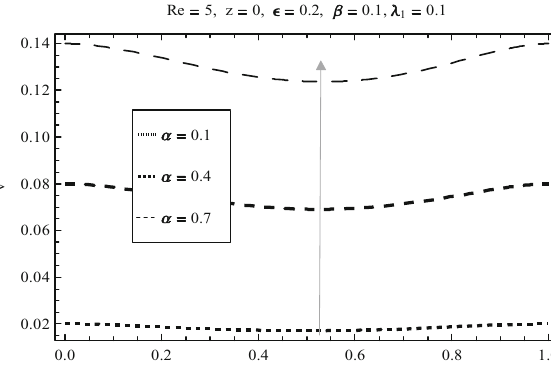
Fig. 6 Velocity component v along y for different values of α